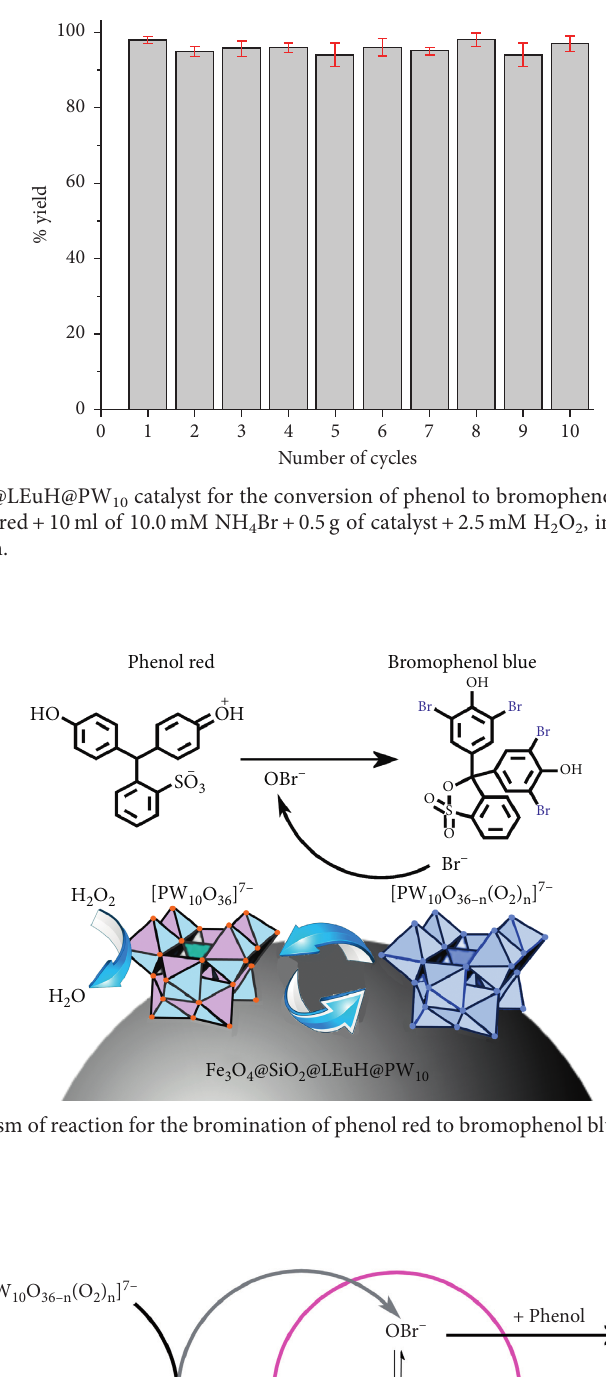
4 Br producing molecular